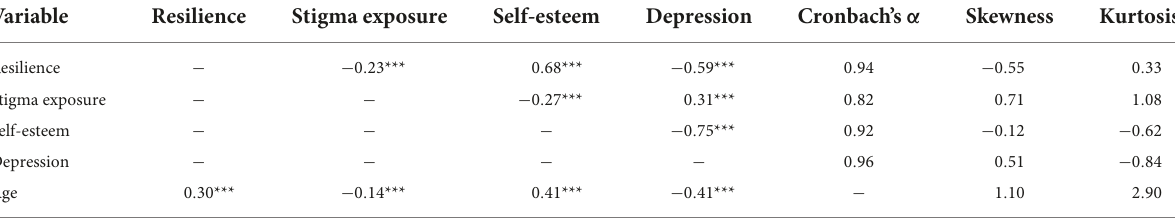
TABLE 2 Correlation matrix and descriptive statistics for studied variables.